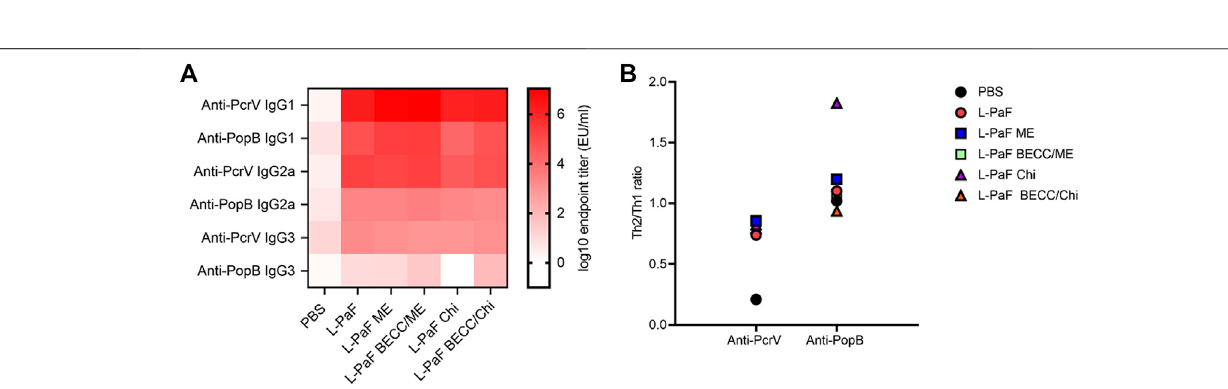
( Figure 5 ). Cells from mice vaccinated with L-PaF alone or with BECC438/ME that were treated with PcrV had signi fi cantly higher frequencies of IL-17A secreting cells compared to the control groups. While IL-17A secreting cells were also found after treatment with PopB, no statistical signi fi cance was observed. Negative control cells (not receiving any protein stimulation) did not show any signi fi cant IL-17A secreting cells either (data not shown).